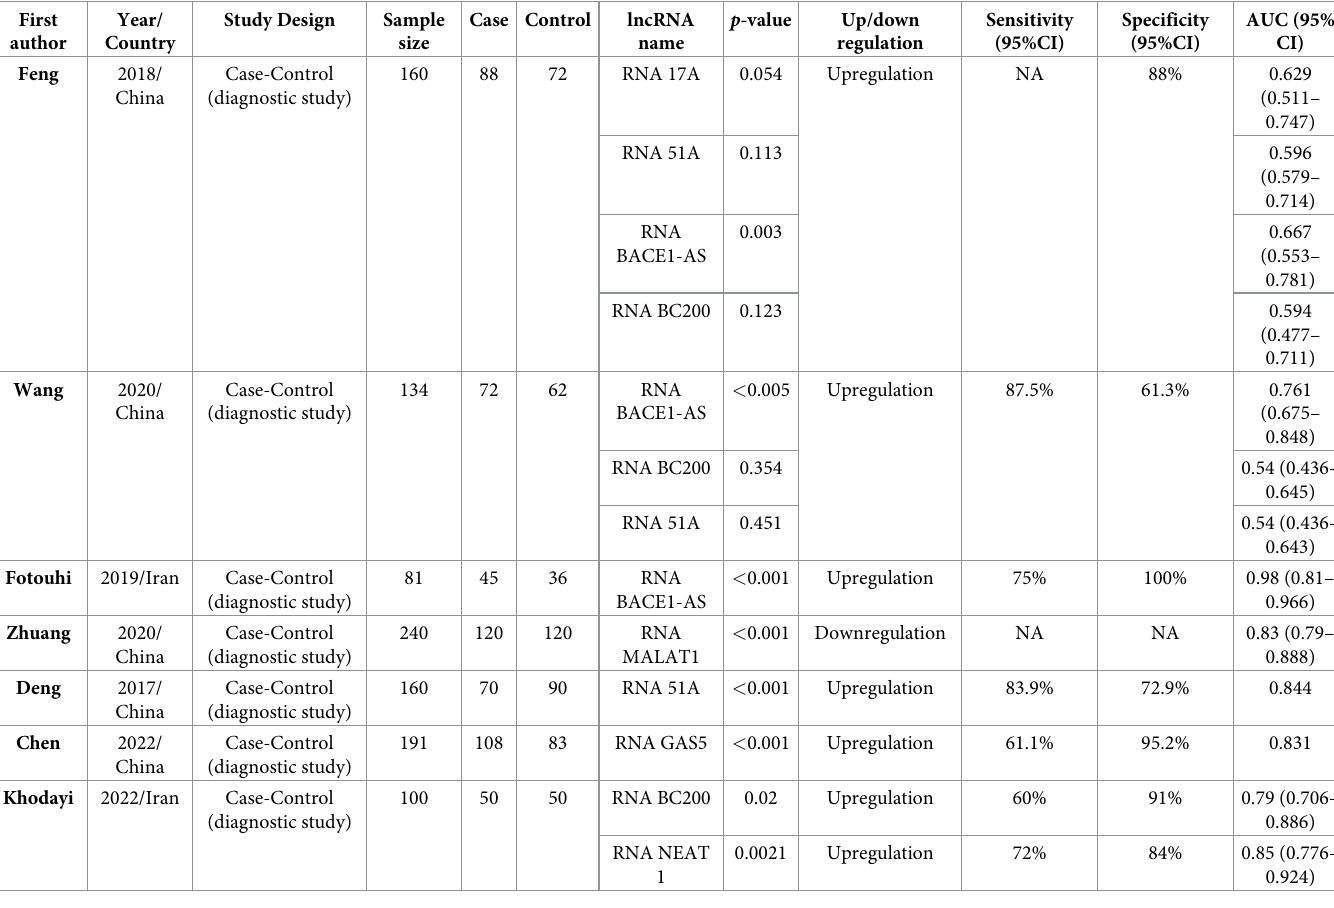
Table 1. Summary of peer-reviewed studies reporting the association and accuracy of lncrnas collected through plasma samples in patients with Alzheimer’s